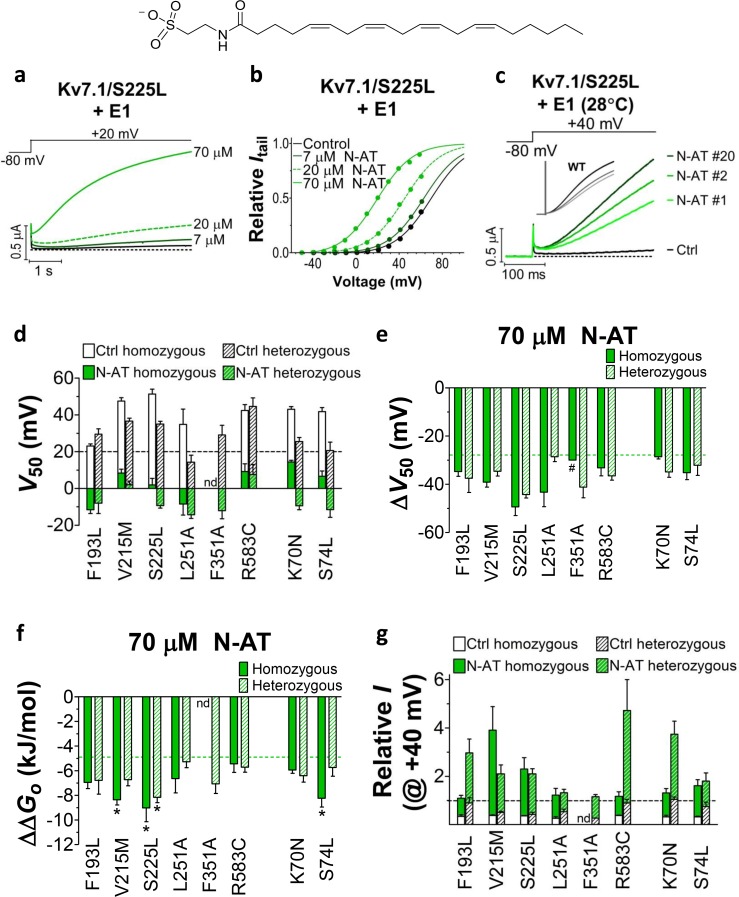
Effect of N-AT on LQTS and LQTS-like mutants.All these experiments are done in the presence of KCNE1. Structure of N-AT is shown. (a–b) Representative effect of 7–70 µM N-AT on current amplitude (a) and G(V) (b) of KV7.1/S225L+KCNE1. Dashed line in (a) denotes 0 µA. (c) Representative currents generated by KV7.1/S225L+KCNE1 during pulsing at 1 Hz and +28°C in control solution (black) and after the cell had been bathed continuously in 70 µM N-AT (light to dark green, # denotes sweep order). Inset: corresponding currents from wild-type KV7.1+KCNE1 scaled similarly as KV7.1/S225L+KCNE1. Light grey trace denotes sweep #1, grey trace denotes sweep #2, and dark grey trace denotes sweep #20. (d) Summary of V50 for LQTS and LQTS-like mutants before and after 70 µM N-AT application. Dashed line denotes V50 for wild-type KV7.1+KCNE1. (e–f) Summary of ΔV50 (e) and ΔΔGo (f) for LQTS and LQTS-like mutants induced by 70 µM N-AT. # denotes an approximation. Dashed lines denote corresponding ΔV50 and ΔΔGo induced by 70 µM N-AT for wild-type KV7.1+KCNE1. The statistics in (f) represent one-way ANOVA with Dunnett’s Multiple Comparison Test to compare the N-AT-induced change in ΔΔGo of mutants to N-AT-induced change in ΔΔGo of wild-type KV7.1+KCNE1; *p≤0.05. Only significant differences shown in (f), other comparisons have p>0.05. (g) Estimate of the ability of 70 µM N-AT to restore LQTS and LQTS-like mutant current amplitude at +40 mV. The mean N-AT induced increase in current amplitude for each mutant (from Figure 4—figure supplement 4b) is multiplied with the control amplitude for each mutant (from Figure 1—figure supplement 4d). Not determined (nd). Data as mean ± SEM. n = 5–12. Dashed line denotes relative wild-type KV7.1+KCNE1 current amplitude in control solution (i.e. without N-AT).